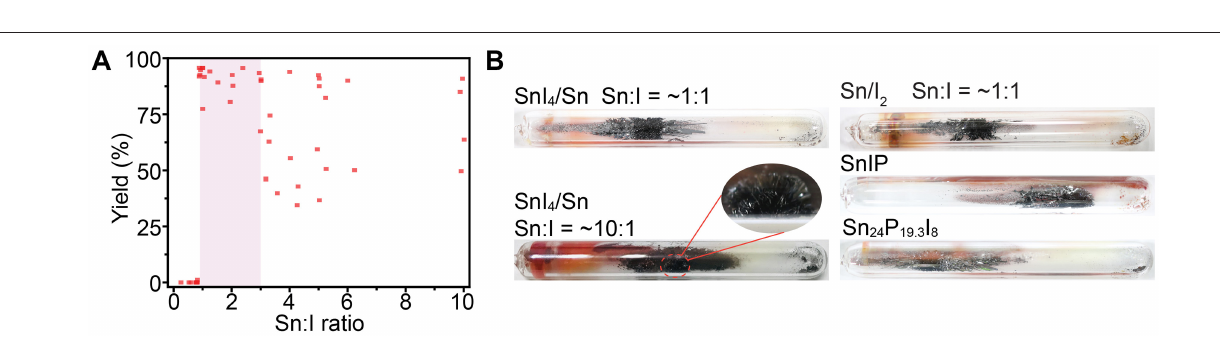
FIGURE 2 | (A) Distribution of the synthetic yield of BP crystals against Sn:I ratio in the SnI 4 /Sn assisted reaction. (B) Photos of BP crystals in ampoules obtained in the presence of different